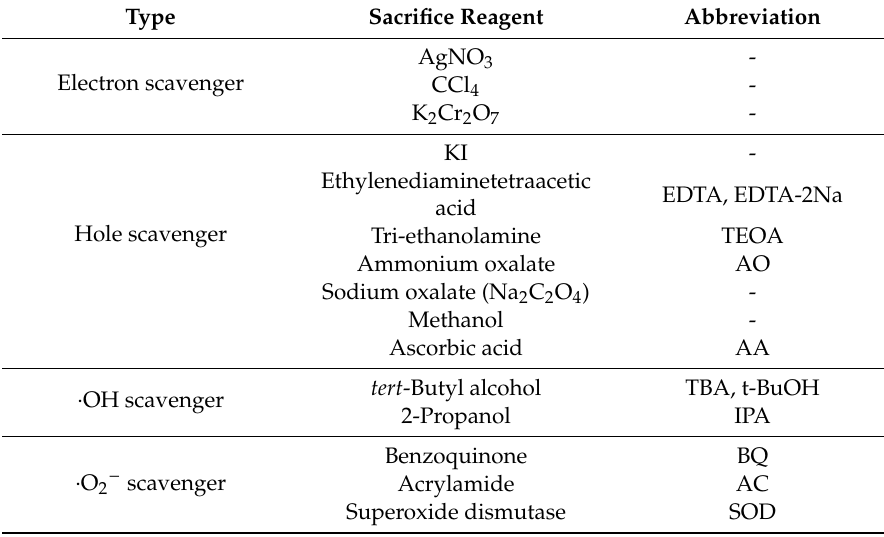
Table 2. Common scavengers used for active species trapping